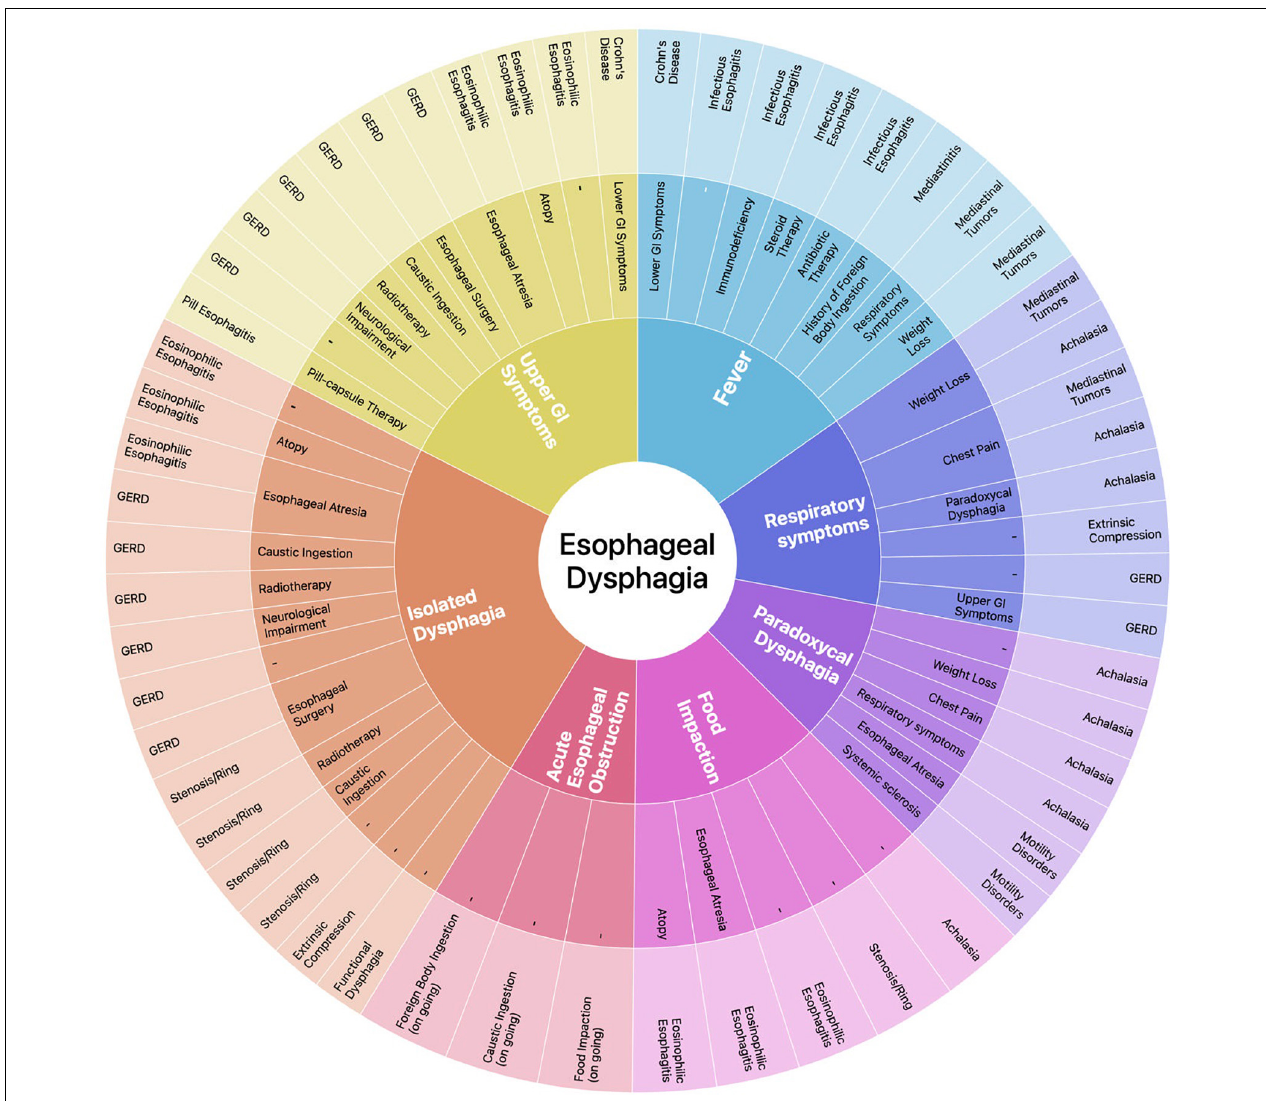
FIGURE 3 | Sunburst diagram representing our proposed symptom-based diagnostic approach to ED. The diagram consists of four concentric circles (or levels) which, from the inside to the outside, represent in a hierarchical relation: (1) the clinical key elements that guide the diagnostic process; (2) relevant complementary symptoms and disease factors predisposing to a specific etiology that, in addition to the corresponding clinical key element, may address the differential diagnosis; (3) the most probable etiologic diagnosis/diagnoses of ED based on the clinical elements selected in the underlying levels. Each clinical key element is represented in a different color and this color is maintained throughout the corresponding section of the graph, albeit with different tones along the different levels (i.e., rings 1, 2, 3). Relevant complementary symptoms and predisposing factors in ring 2 make the etiologic diagnosis in ring 3 more likely; when no element is indicated it means that the final diagnosis may not be associated to any other clinical element. A dynamic version of the diagram is available in Supplementary Material